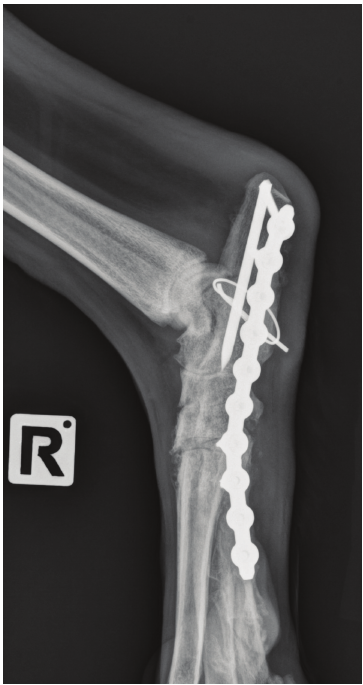
Figure 3: Nine-week postoperative radiograph showing satisfactory healing of calcaneal